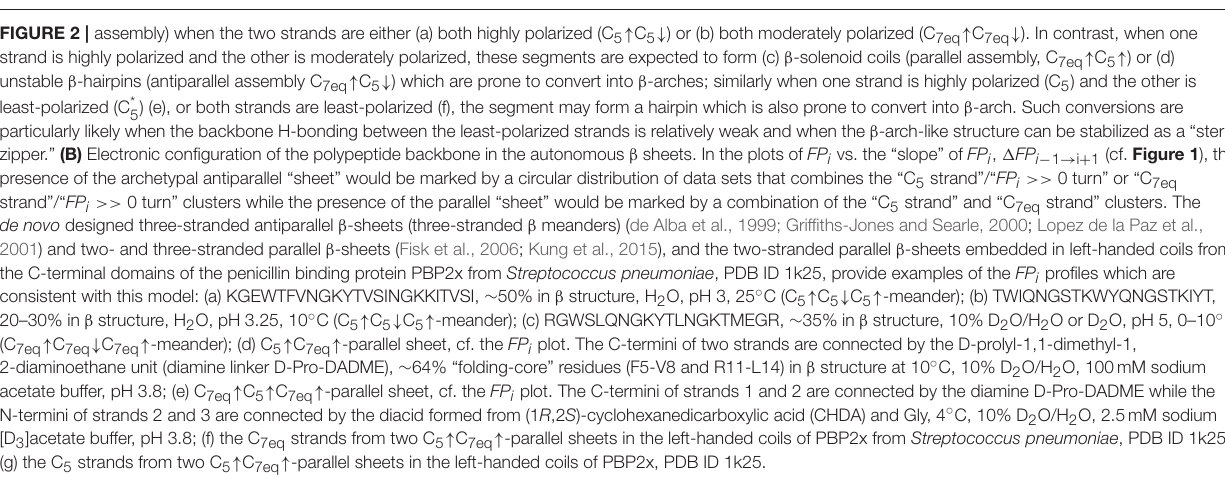
FIGURE 2 | assembly) when the two strands are either (a) both highly polarized (C 5 ↑ C 5 ↓ ) or (b) both moderately polarized (C 7eq ↑ C 7eq ↓ ). In contrast, when one strand is highly polarized and the other is moderately polarized, these segments are expected to form (c) β -solenoid coils (parallel assembly, C 7eq ↑ C 5 ↑ ) or (d) unstable β -hairpins (antiparallel assembly C 7eq ↑ C 5 ↓ ) which are prone to convert into β -arches; similarly when one strand is highly polarized (C 5 ) and the other is least-polarized (C * 5 ) (e), or both strands are least-polarized (f), the segment may form a hairpin which is also prone to convert into β -arch. Such conversions are particularly likely when the backbone H-bonding between the least-polarized strands is relatively weak and when the β -arch-like structure can be stabilized as a “steric zipper.” (B) Electronic configuration of the polypeptide backbone in the autonomous β sheets. In the plots of FP i vs. the “slope” of FP i , 1 FP i − 1 → i + 1 (cf. Figure 1 ), the presence of the archetypal antiparallel “sheet” would be marked by a circular distribution of data sets that combines the “C 5 strand”/“ FP i >> 0 turn” or “C 7eq strand”/“ FP i >> 0 turn” clusters while the presence of the parallel “sheet” would be marked by a combination of the “C 5 strand” and “C 7eq strand” clusters. The de novo designed three-stranded antiparallel β -sheets (three-stranded β meanders) (de Alba et al., 1999; Griffiths-Jones and Searle, 2000; Lopez de la Paz et al., 2001) and two- and three-stranded parallel β -sheets (Fisk et al., 2006; Kung et al., 2015), and the two-stranded parallel β -sheets embedded in left-handed coils from the C-terminal domains of the penicillin binding protein PBP2x from Streptococcus pneumoniae , PDB ID 1k25, provide examples of the FP i profiles which are consistent with this model: (a) KGEWTFVNGKYTVSINGKKITVSI, ∼ 50% in β structure, H 2 O, pH 3, 25 ◦ C (C 5 ↑ C 5 ↓ C 5 ↑ -meander); (b) TWIQNGSTKWYQNGSTKIYT, 20–30% in β structure, H 2 O, pH 3.25, 10 ◦ C (C 5 ↑ C 5 ↓ C 5 ↑ -meander); (c) RGWSLQNGKYTLNGKTMEGR, ∼ 35% in β structure, 10% D 2 O/H 2 O or D 2 O, pH 5, 0–10 ◦